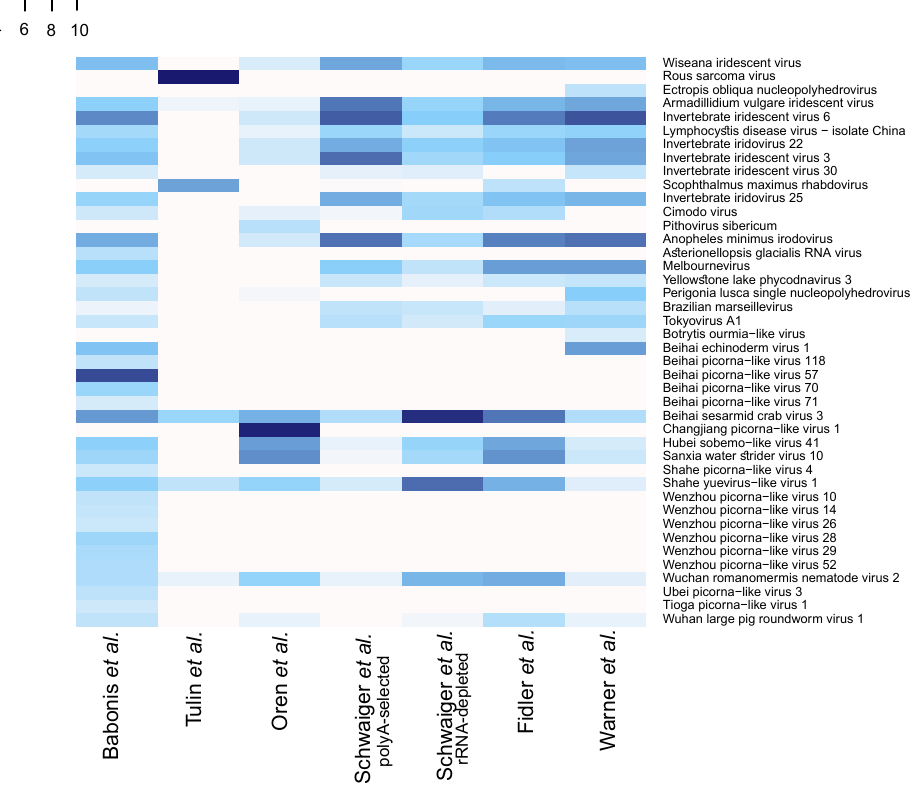
Figure 2. Relative abundance of viral sequences in each analyzed dataset presented as log 2 of transcript per thousand (TPM / 1000). Sequences representing fragments of the same viral species were collapsed into one